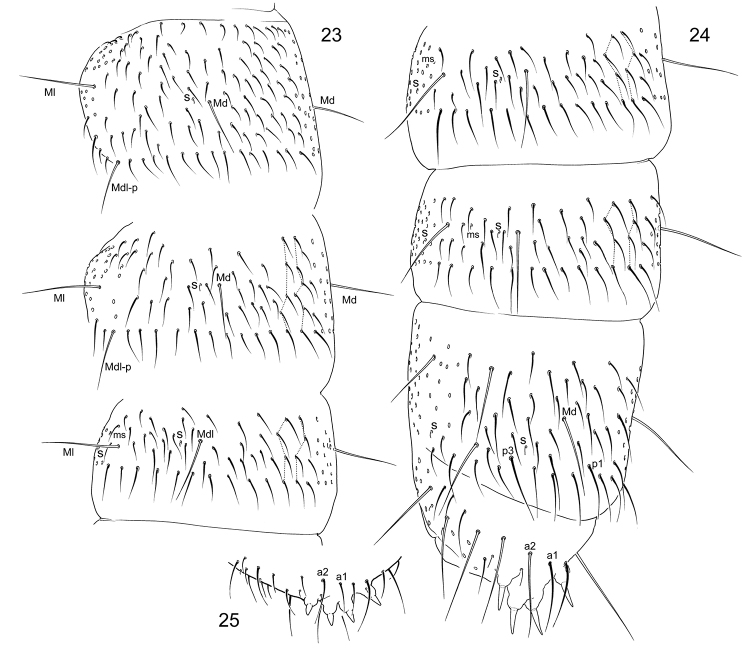
Tetracanthellamanschurica23–24 dorsal chaetotaxy, dorsal view (Vaninski district) 25 anal spines (Chuguevski district).